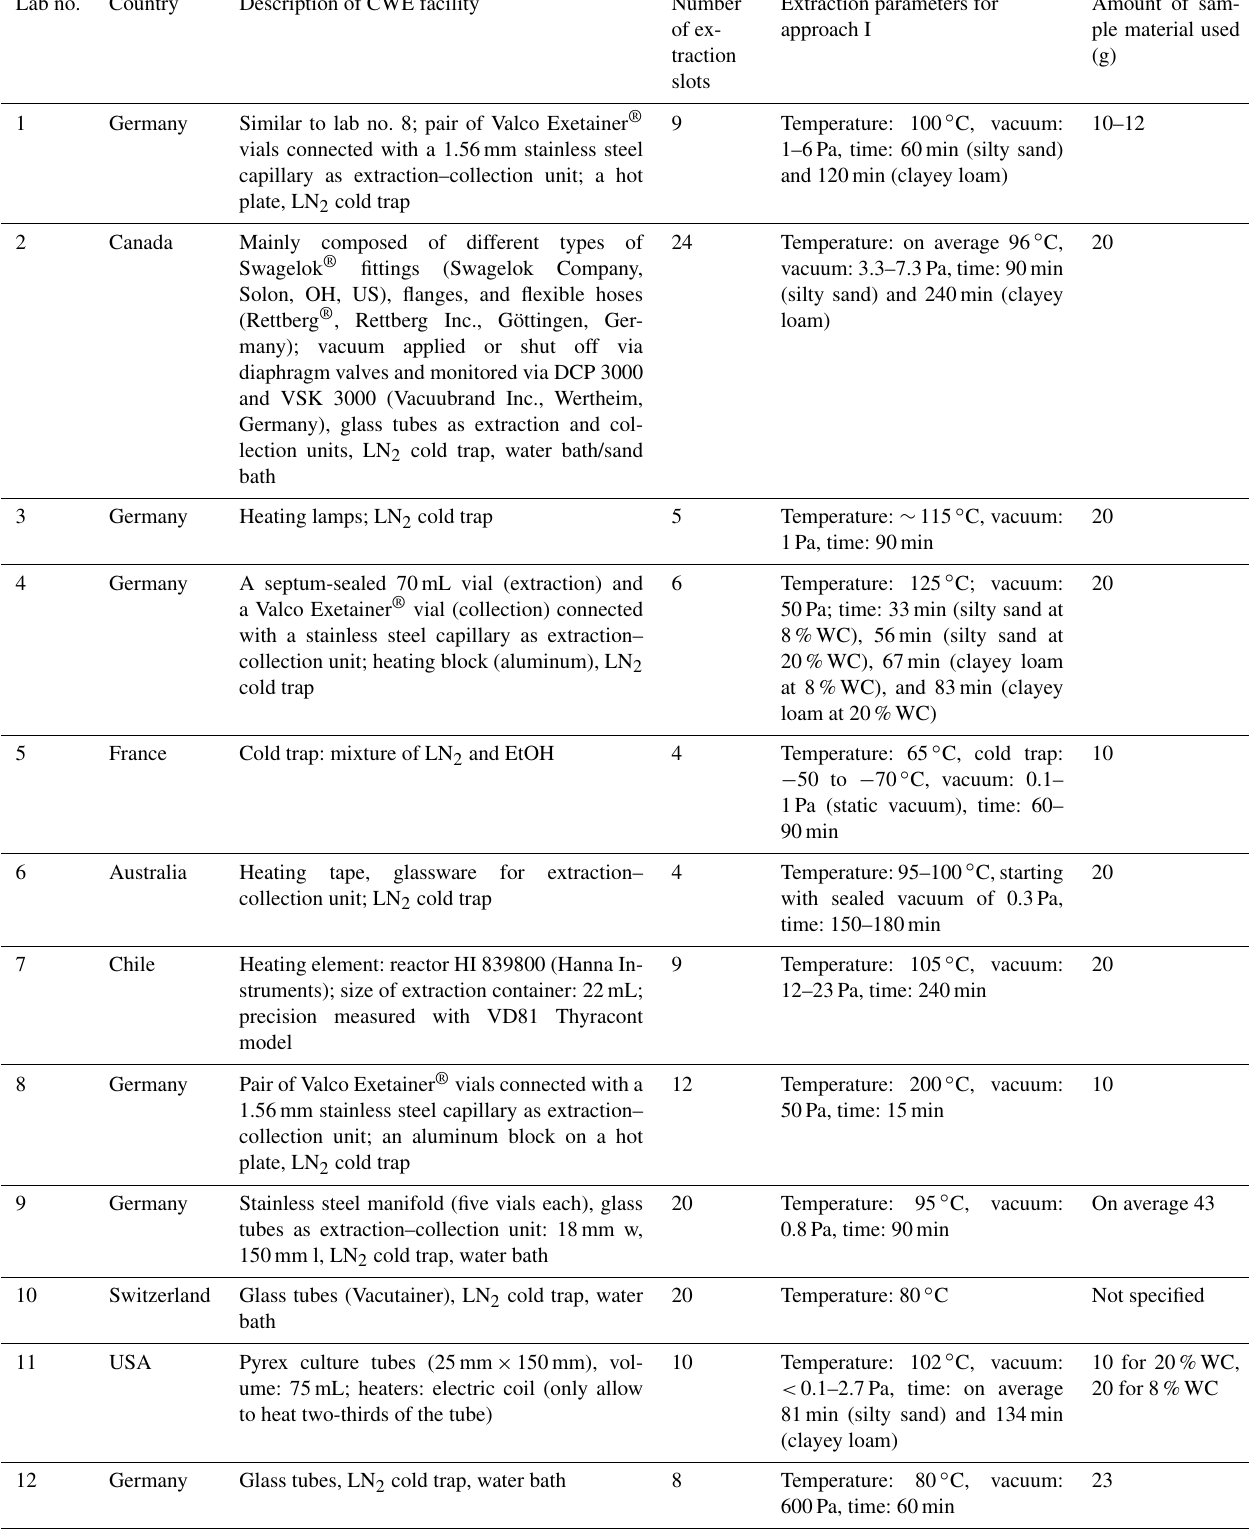
Table 1. Description of the respective extraction systems that participated in the cryogenic inter-laboratory comparison, the applied extraction parameters for extraction approach I, and the amount of sample material used for both extraction methods (lab procedure: I; predefined: II). Note that not every lab provided the same detailed